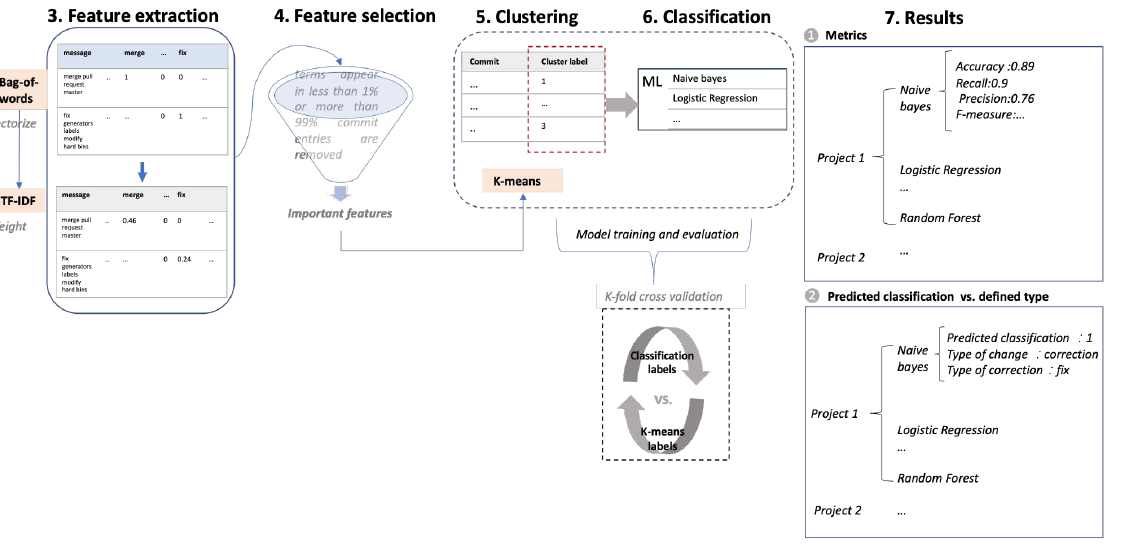
Figure 1. Methodology